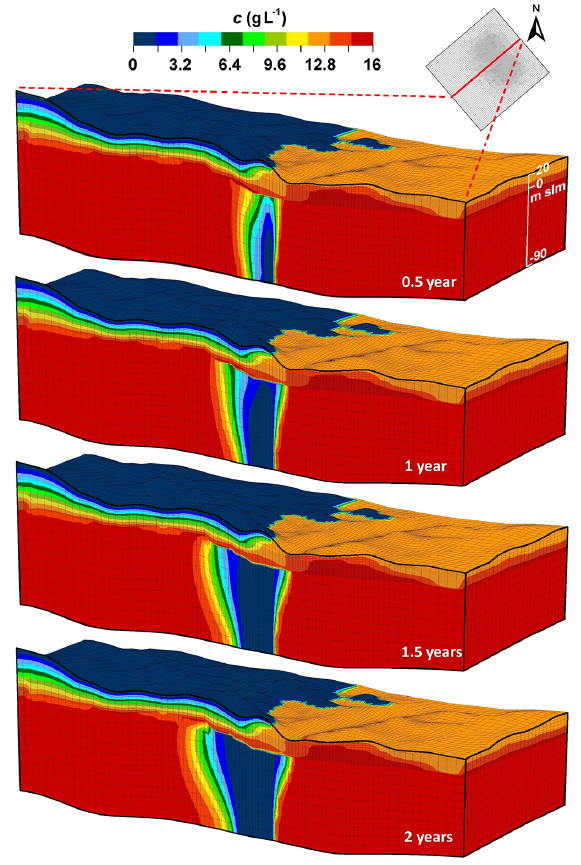
Figure 14. Scenario S 3A showing the evolution of the salt concen- tration (gL − 1 ) on a vertical section through the barycenter of the injection configuration. The vertical exaggeration is 10.